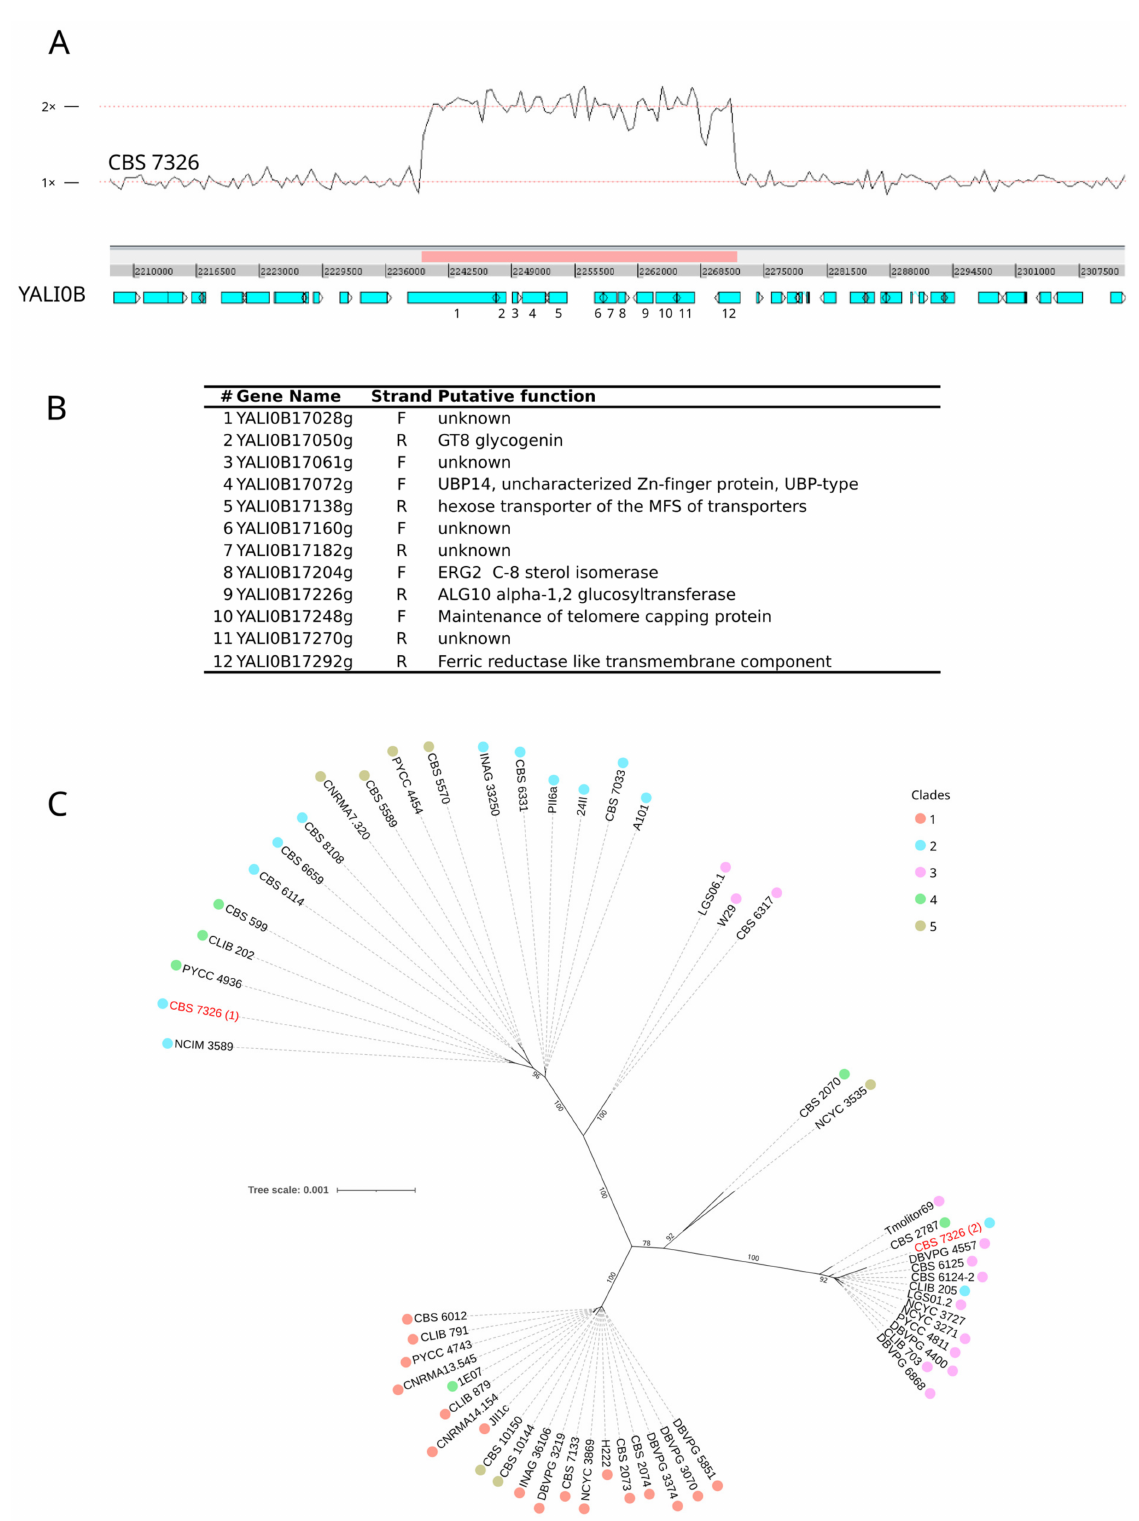
Figure 2. Region of 32 kb on chromosome Yali0B is duplicated in strain CBS 7326 between positions 2,239,806 and 2,271,919 of the E150 reference genome. ( A ) read mapping depth plot of the region, ( B ) list of genes present in this region, ( C ) maximum likelihood phylogenetic tree obtained using IQ-TREE (best evolution model according to BIC: HKY + F + I). The two copies of the region present in CBS 7326 are in red. Bootstrap values are